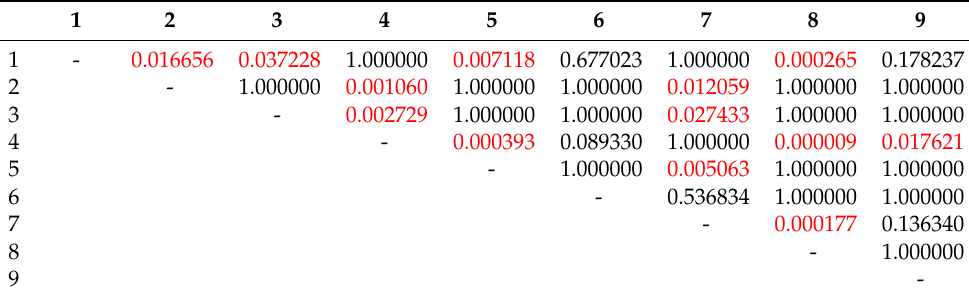
Ageing protocols: control-water, 24 h, 37 ◦ C; thermocycling + NaOH-water, 7500 thermo cycles, 5/55 ◦ C and 0.1 M NaOH, 7 days, 60 ◦ C; 5d water + NaOH-water, 5 days, 55 ◦ C and 0.1 M NaOH, 7